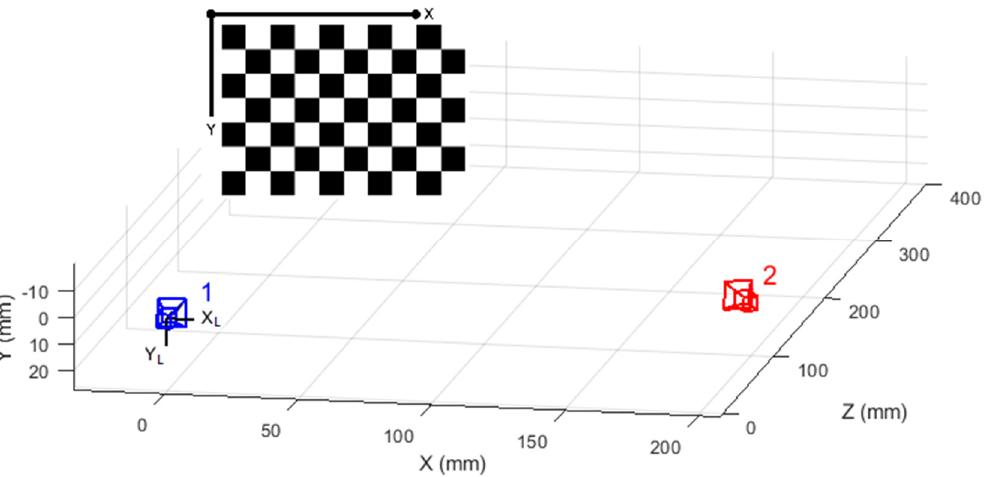
Figure 6. Calibration plate and its position relative to the camera array during calibration: 1—left camera (initial coordinate system of the video system) and 2—right camera. Table 2. Internal camera parameters obtained during calibration in the Matlab environment.